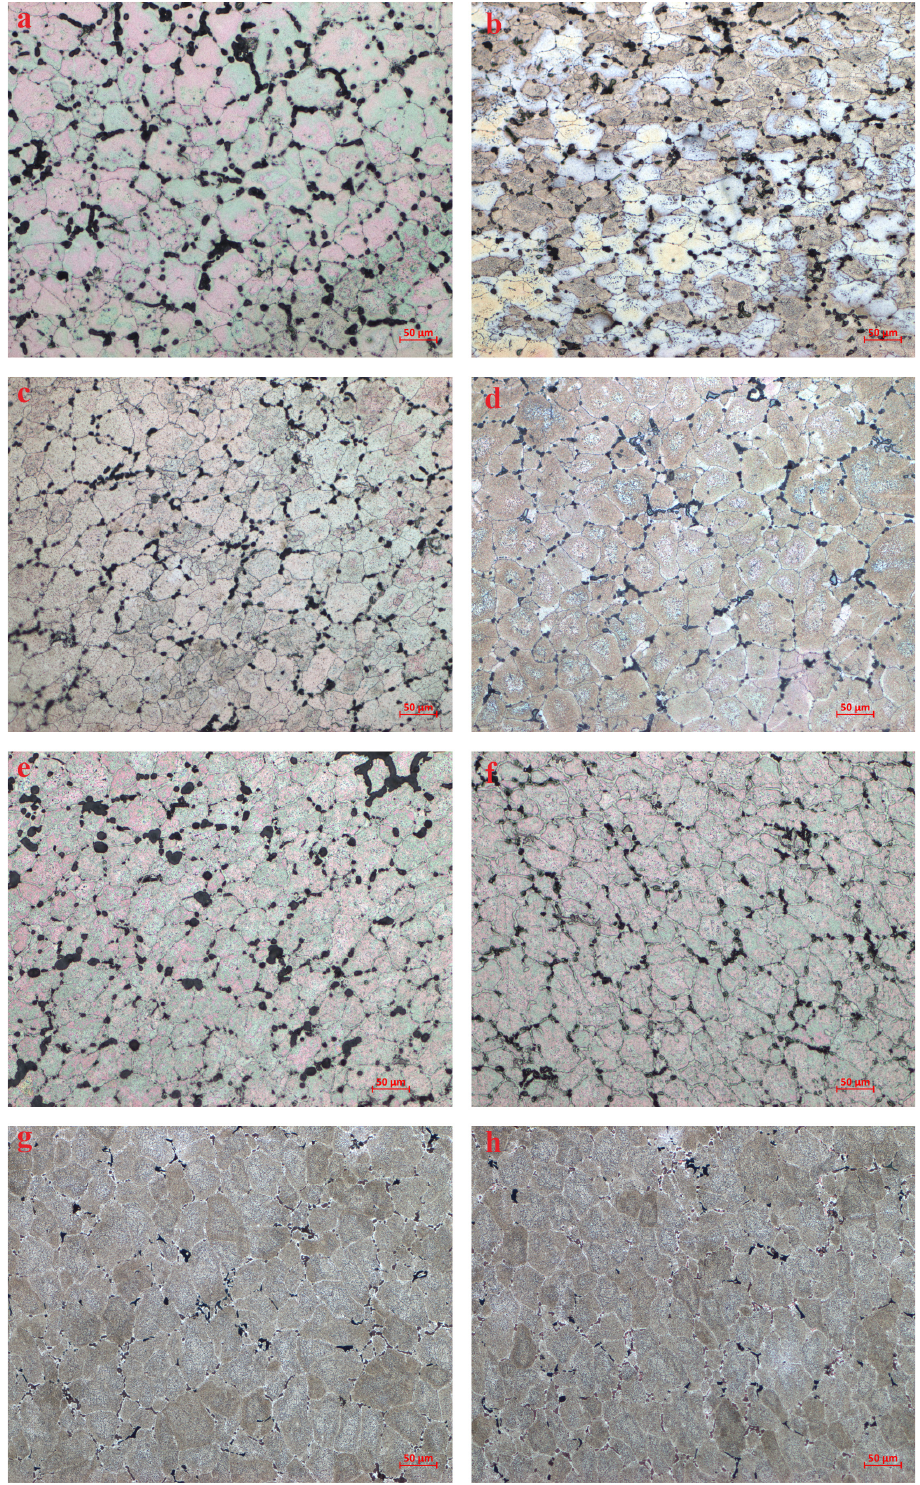
Figure 6. Gleeble specimen metallographic micrograph 2. ( a ) 440 °C—0.01; ( b ) 440 °C—0.1; ( c )